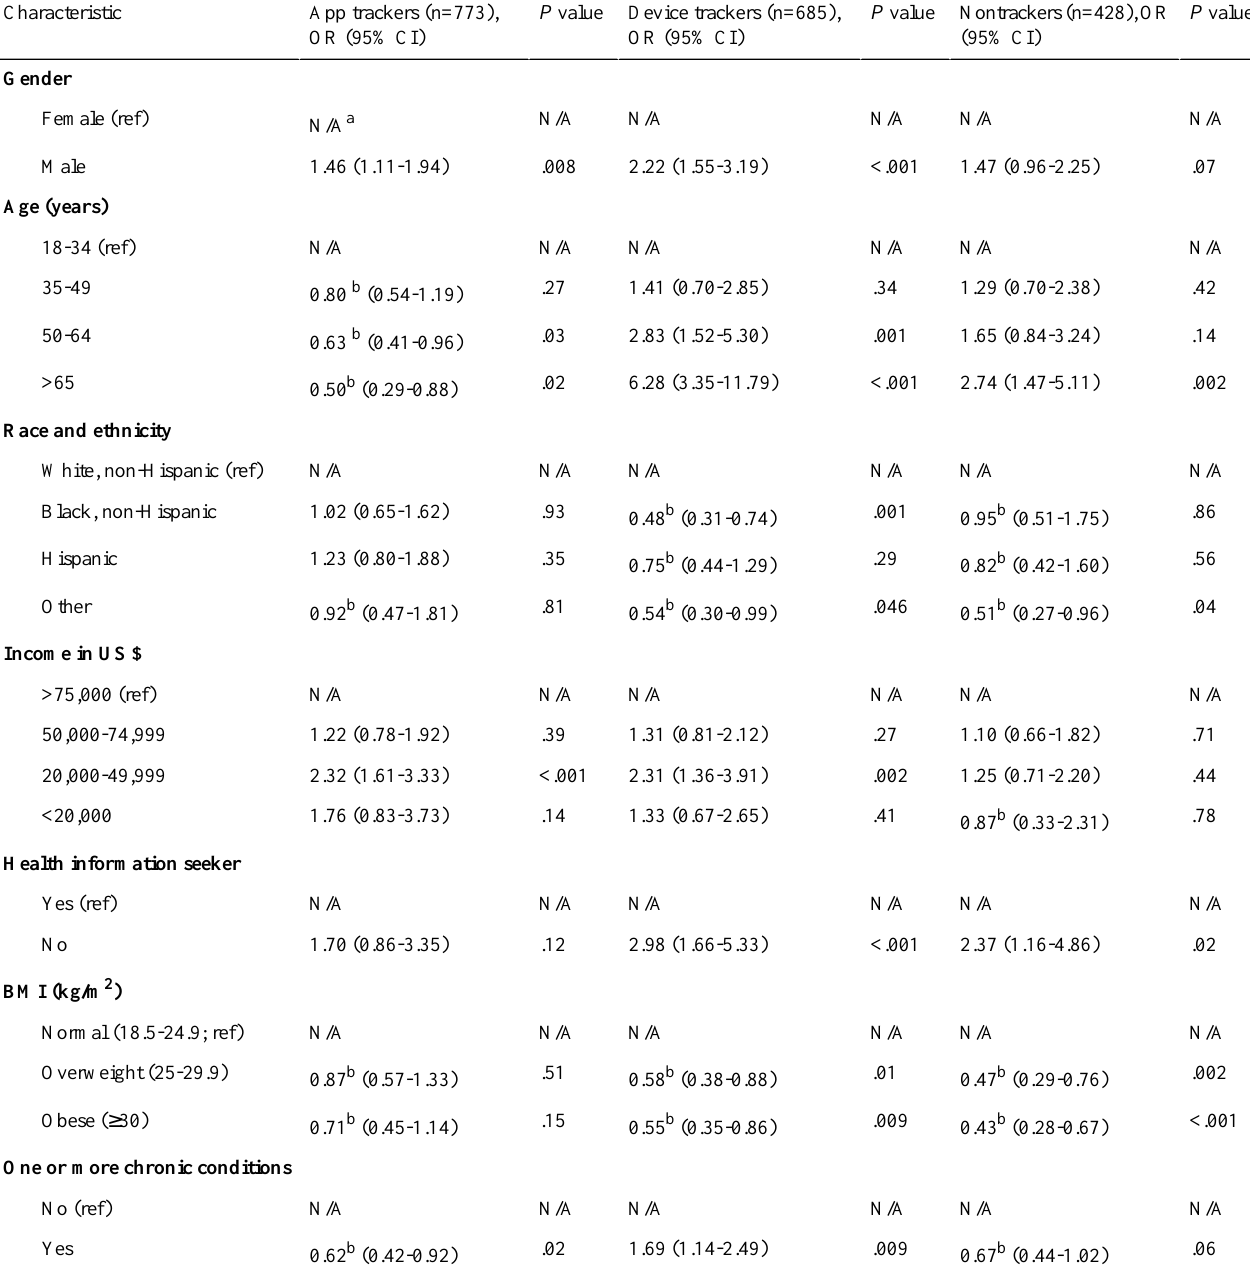
Table 3. Characteristics significantly associated with being a mobile health (mHealth) owner and user by pattern of mHealth use for health and behavioral tracking. Reference category=Supertrackers